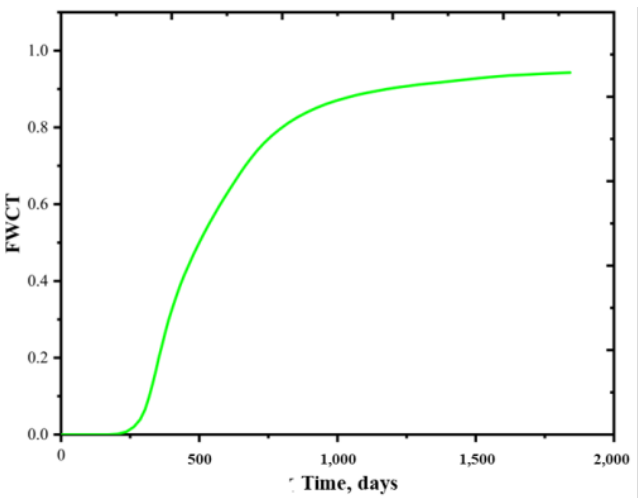
Figure 24. Field water cut for vertical wells.